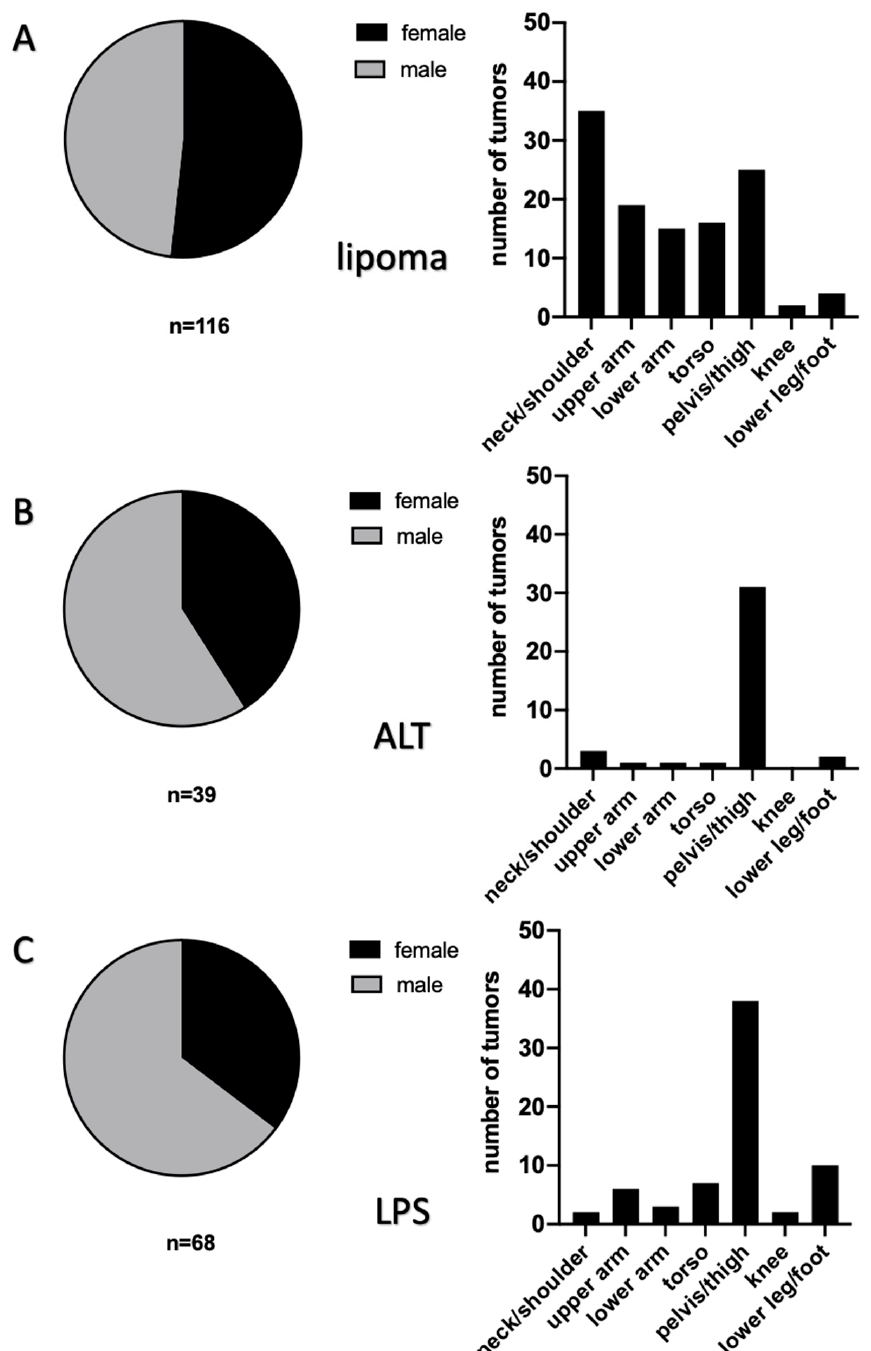
Figure 2. Gender distribution and body region distribution of lipomatous tumors. Section ( A ) of the figure gives an overview of gender and body region distribution of lipomata. Likewise, section ( B ) shows that more men than women were affected by ALTs, and by far, most ALTs were found in the pelvis/thigh region ( n = 31). Section ( C ) depicts the results for LPSs. A total of 44 LPSs were identified in male patients, in contrast to 24 in females. The highest incidence per region was found in the pelvis/thigh region ( n = 38).